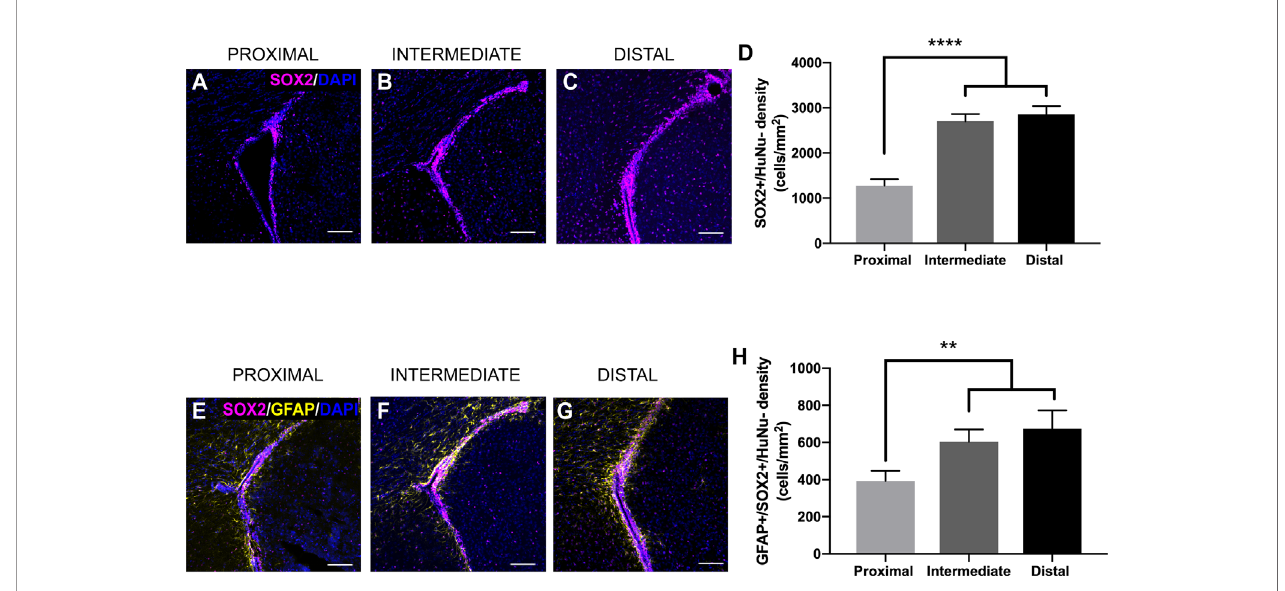
FIGURE 4 | SVZ SOX2+ progenitor number is altered by LV-proximal GBM. (A – C) Representative images of SOX2+ cells in the GFP-/HuNu- cells of the SVZ in (A) LV-proximal, (B) LV-intermediate, and (C) LV-distal groups. Scale bar = 100 m m. (D) Quanti fi cation of SOX2+ cell density in the SVZ of LV-proximal, LV- intermediate, and LV-distal GBM mice. (E – G) Representative images of GFAP+/SOX2+ cells in the SVZ of (E) LV-proximal, (F) LV-intermediate, and (G) LV-distal groups. Scale bar = 100 m m. (H) Quanti fi cation of GFAP+/SOX2+ cell density in the SVZ of LV-proximal (n = 7), LV-intermediate (n = 5), and LV-distal (n = 5) GBM mice. Data are presented as mean ± SEM. ** p < 0.01, **** p <